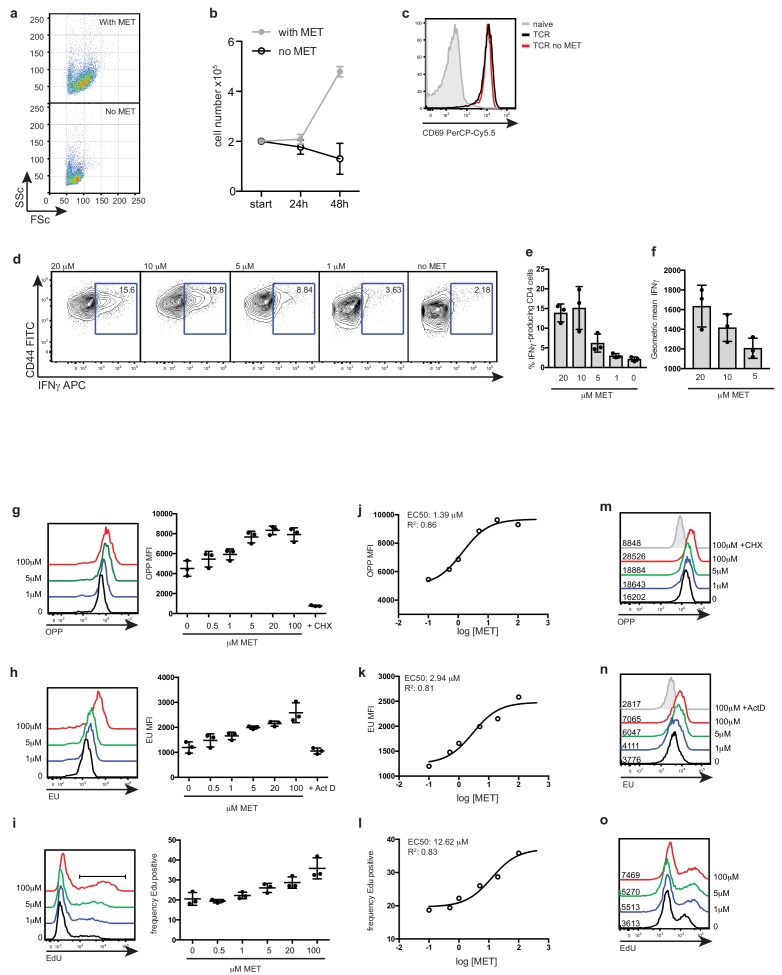
T cell activation and differentiation requires a sustained supply of extracellular methionine.(a) Flow cytometry plots show the forward (FSC) and side (SSC) scatter profiles of CD4+ T cells stimulated through the TCR (CD3/CD28) for 18 hr ± methionine. (b) Cell counts of CD4+ T cells over 48 hr after TCR-stimulation (CD3/CD28) in the presence or absence of methionine. (c) Flow cytometry plots CD69 expression of CD4+ T cells stimulated through the TCR (CD3/CD28) for 18 hr ± methionine. (d-f) CD4+ T cells activated with CD3/CD28 antibodies + IL2/IL12 for 3 days in indicated methionine concentrations. (d) CD44 surface staining and intracellular IFNγ cytokine staining. The % CD4+ T cells producing IFNγ is indicated on the plot. The percentage (e) and MFI (f) of IFNγ producing CD4+ T cells from three biological replicates. (g–l) CD4+ T cells were stimulated through the TCR (CD3/CD28) for 20 hr before culturing in reducing concentrations of methionine for a further 2 hr. The histograms (left panel) show de novo protein synthesis as measured by incorporation of the puromycin analog (OPP) (g) or RNA synthesis as determined by EU incorporation (h). The right panels show the MFIs over the expanded dose response. Cyclohexamide (CHX) treatment or Actinomycin D (ActD) treatment are included as negative controls for protein and RNA synthesis. (i) The histograms (left panel) show the frequency of CD4+ T cells undergoing DNA synthesis as measured by EdU incorporation. The right panel shows the frequency of EdU positive cells over the expanded dose response. (j–l) EC50 values were calculated from dose response curves (using logged concentration values). Goodness of fit is represented by the R2 values. (m–o) Th1 effector cells were expanded for 5 days before culturing in reducing concentrations of methionine for a further 5 hr. The histograms show (m) de novo protein synthesis (n) RNA synthesis and (o) DNA synthesis. (Plots are representative of 3 biological replicates. Gating strategies are provided in Supplementary file 1. Error bars are mean ± s.d of: three biological replicates; Points on the graphs indicate biological replicates.).